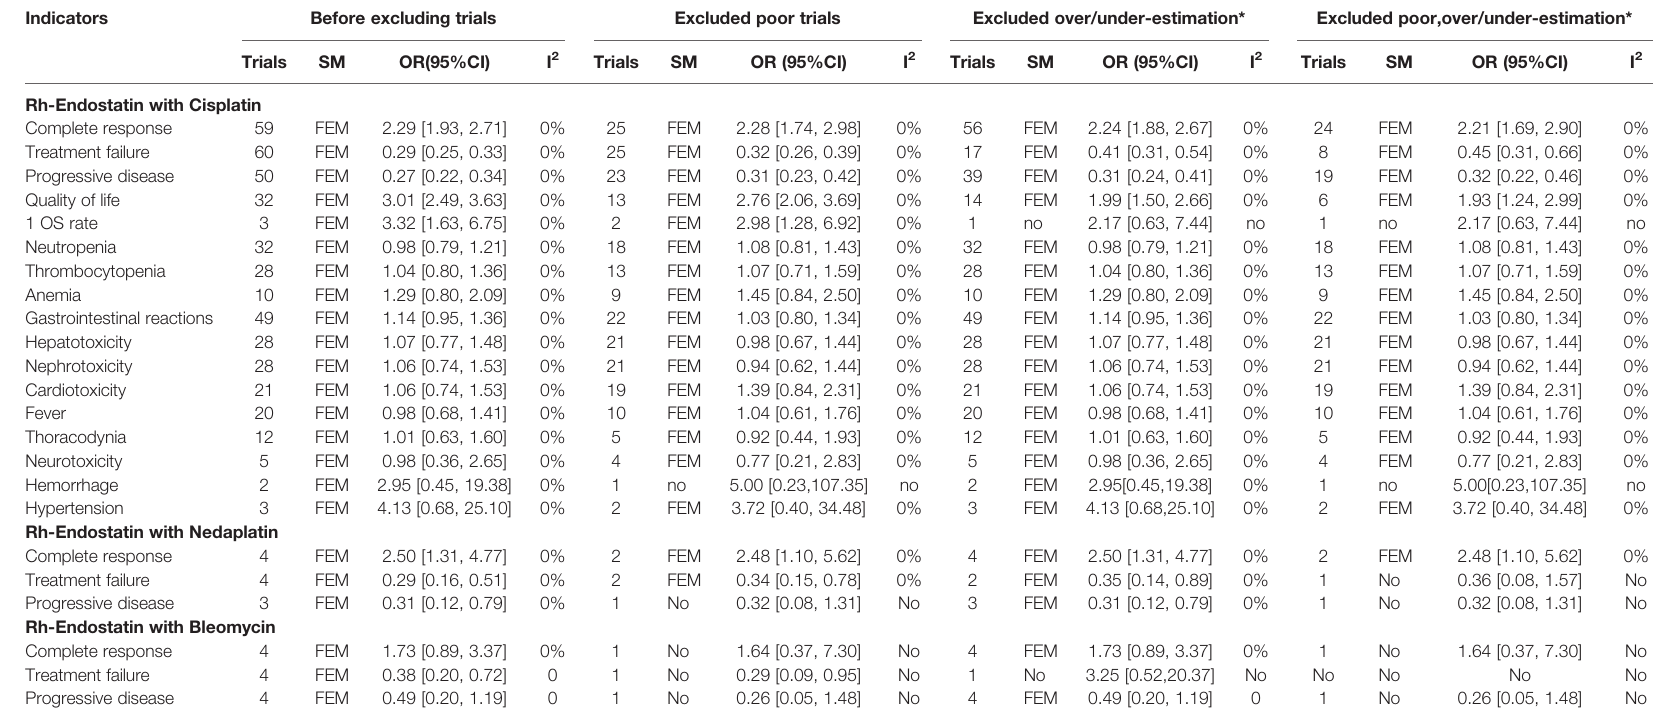
TABLE 4 | Sensitivity